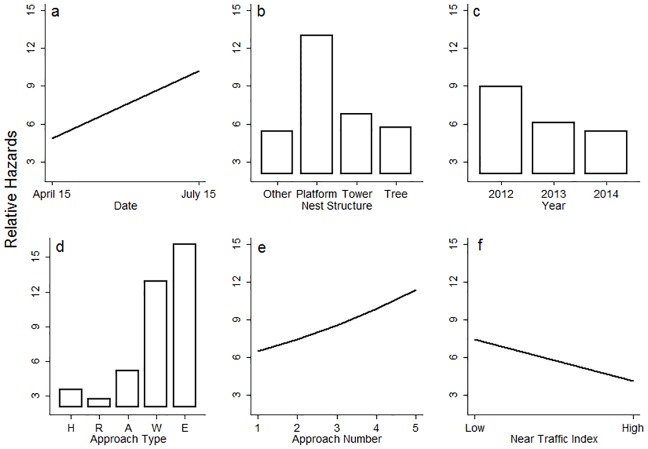
Marginal effects plots demonstrating the effect size, or change to the relative hazards (exp[βi]), defined as relative changes to the probability of flight by adult Ferruginous Hawk from the nest at given distances from the nest, for each covariate in our full model.Each subplot: describes one of six covariates in our full model: a) ordinal date, b) nest structure, c) year, d) approach type, e) approach number, and f) near-traffic index within 4400 m, respectively. H, R, A, W, and E (d) represent driving on highways, range roads, access roads, walking, and exiting the truck, respectively.